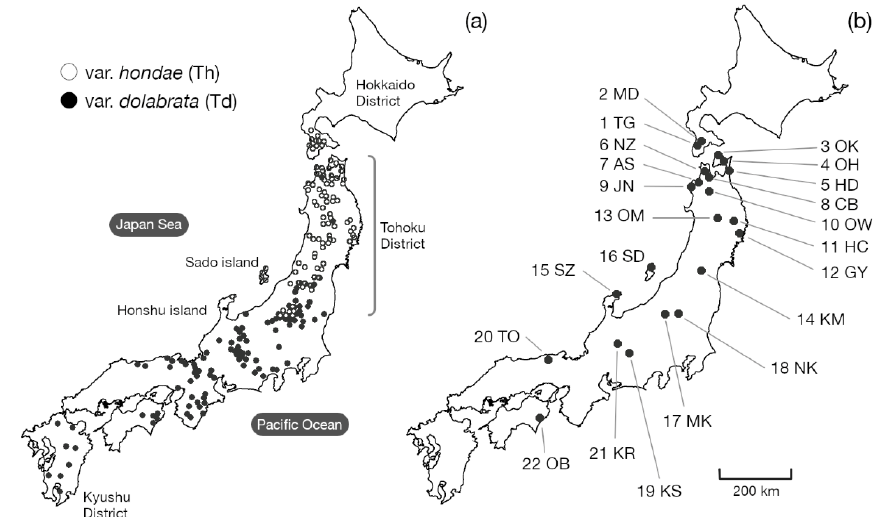
Figure 1. ( a ) Classical distribution range of genus Thujopsis defined by morphological di ff erences between varieties shown in Kurata [9], var. dolabrata (Td, black dots) and var. hondae (Th, white dots). ( b ) Locations of the 22 sampled populations. Numbers correspond to the population numbers in Table 1. Populations 1 to 16 fall within the range of var. hondae and 17 to 22 fall within var. dolabrata .